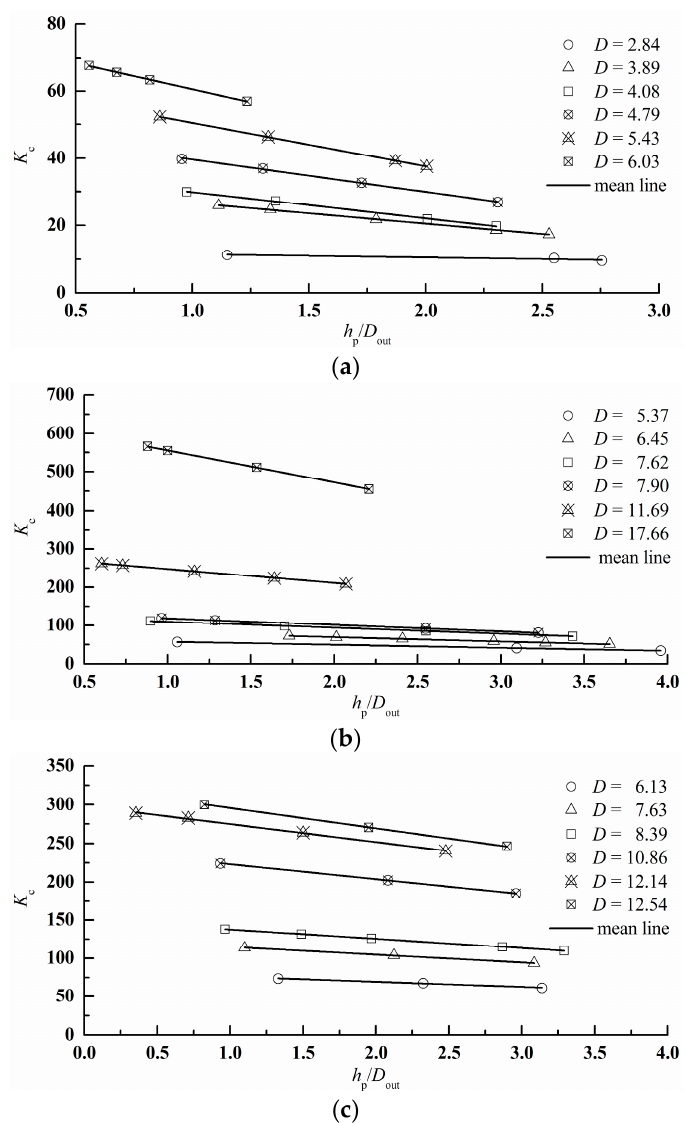
Figure 10. Variation of K c with h p / D out for ( a ) s = 0.93 m, ( b ) s = 1.50 m and ( c ) s = 2.40 m.